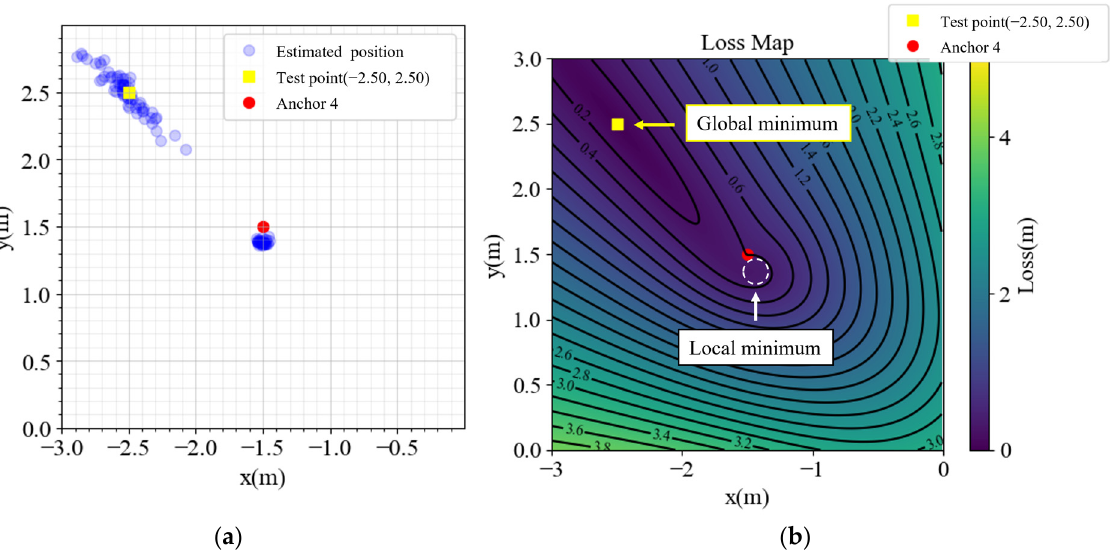
Figure 5. ( a ) Estimated positions and ( b ) loss map of point ( − 2.5, 2.5).